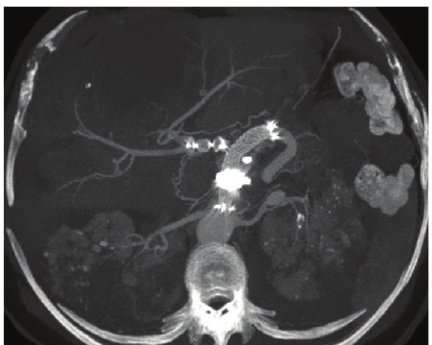
Figure 3: CT scan performed 30 days after the procedure confirming procedural success. MIP reconstruction: complete exclusion of the aneurysm with patency of the Fluency stent in the splenic artery and occlusion of the common hepatic artery with Amplatzer Vascular Plug and Onyx to fill the aneurysm sac. A 1.3cm of the left renal artery is